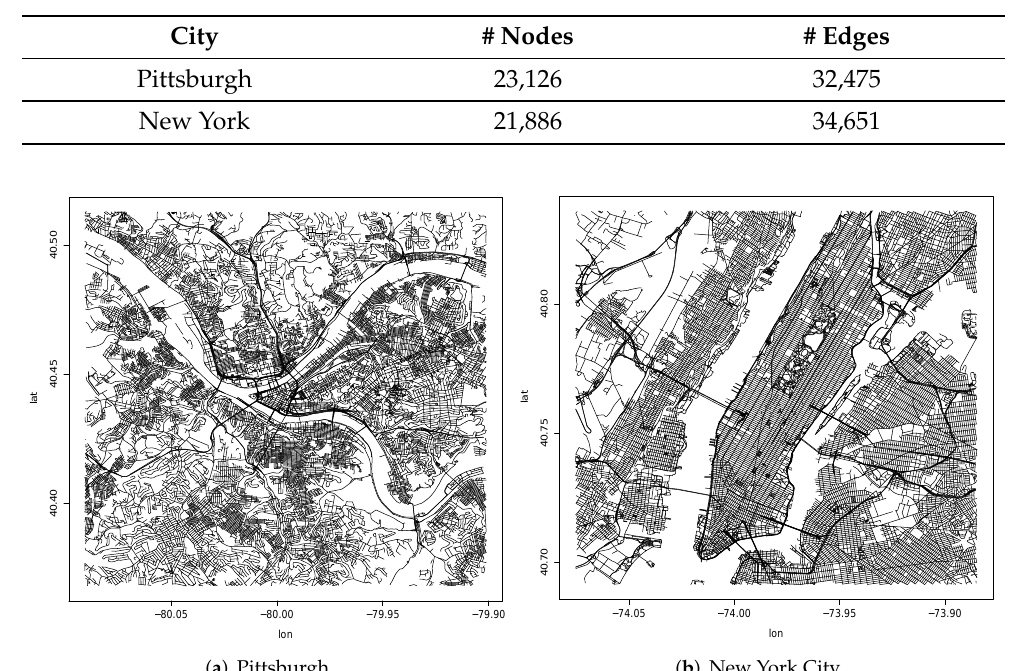
Figure 4. Street network in selected urban areas of two cities, Pittsburgh ( a ) and New York City ( b ). The map data come from OpenStreetMap, with the zoom level, scale ratio and north arrow orientation the same as in Figure